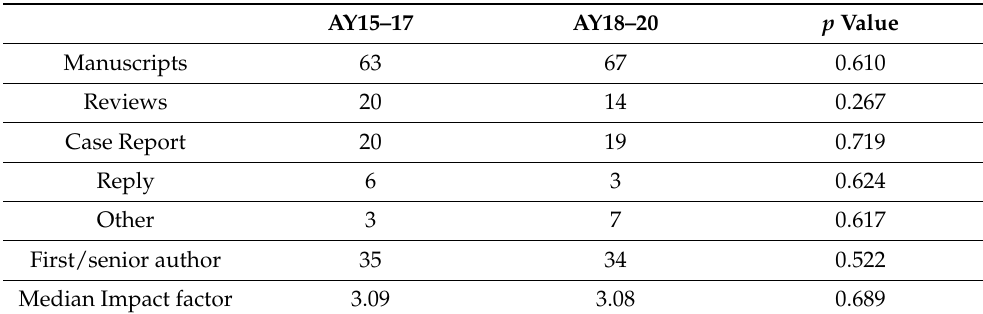
Table 1. Mann–Whitney U pairwise testing of median publications before and after implementation of points system.